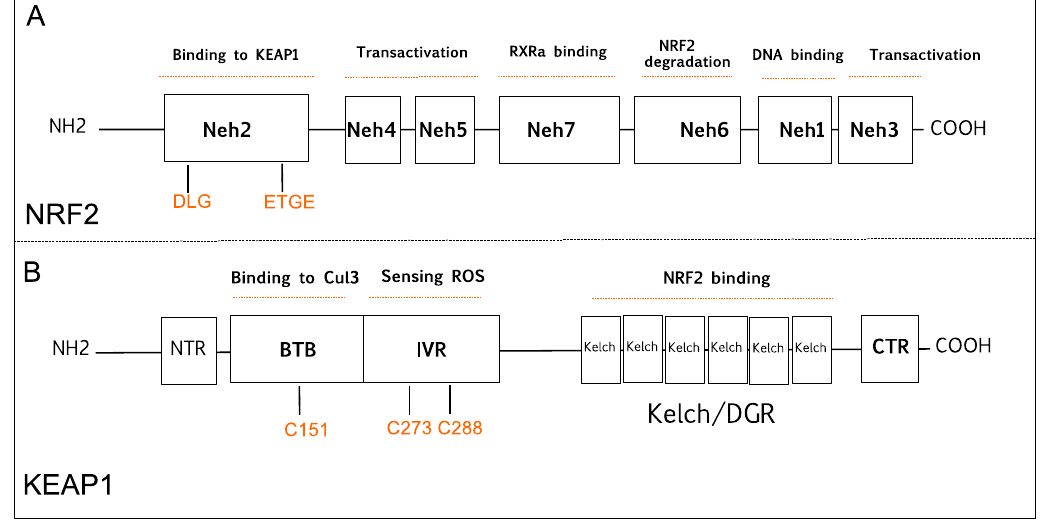
Figure 1. Schematic diagram is showing domain structures of nuclear factor E2-related factor 2 (NRF2), and Kelch-like ECH-associated protein 1 (KEAP1). ( A ) NRF2 has seven domains (Neh1-7). The Neh1 domain is responsible for DNA binding. The Neh2 domain contains DLG and ETGE motifs that are critical for KEAP1 binding. The Neh3, Neh4, and Neh5 are known transactivation domains. The Neh6 is important for proteasomal degradation of NRF2. The Neh7 domain is responsible for RXR α binding. ( B ) KEAP1 has five domains; NTR, CTR, BTB, Bric-a-Brac domain binds to Cul3 that is critical for KEAP1 dimerization; IVR, intervening region contains cysteine residues 273 (C273) and 288 (C288) that are important for sensing reactive oxygen species (ROS); the Kelch/DGR domain is important for NRF2 binding. BTB, Broad complex/Tramtrack/Bric-a-Brac; CTR, carboxy-terminal domain; Cul3, Cullin E3 ubiquitin ligase; IVR, Intervening region; Neh, NRF2-ECH homology; NTR, N-terminal region; RXR α , retinoid X receptor-alpha.